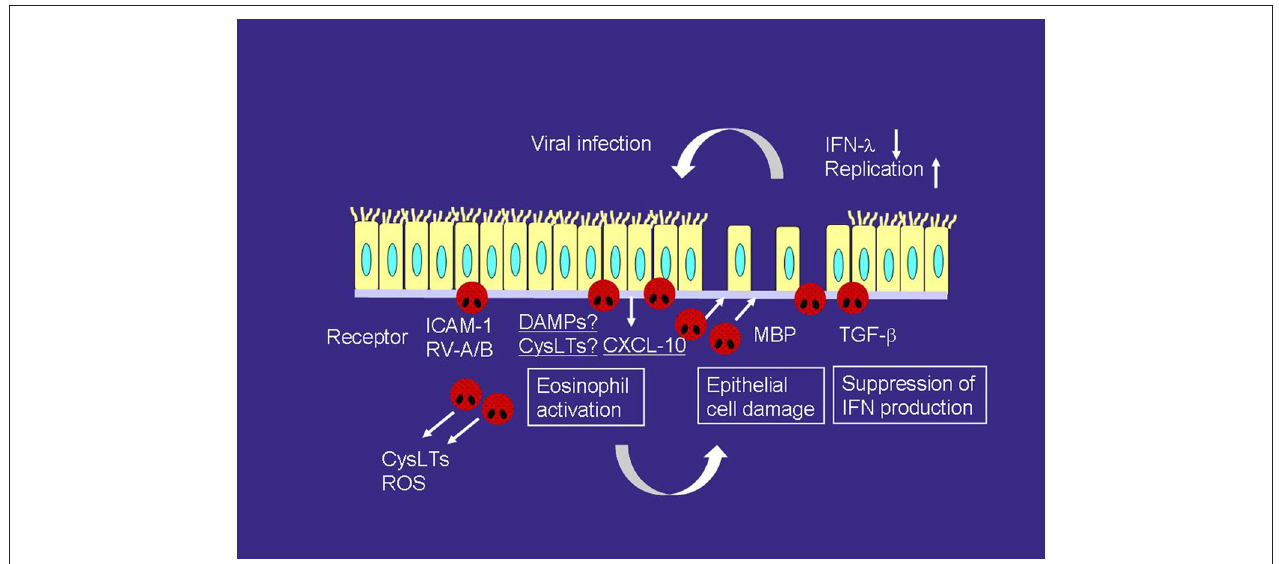
FIGURE 2 | Interactions of viral infection and eosinophils in the development of asthma exacerbation. RV infection releases a variety of mediators, including CXCL-10 and cysLTs, which can directly activate eosinophils and induce asthma exacerbation, from airway epithelial cells. RV infection increases the expression of ICAM-1, which also activates eosinophils. On the other hand, activated eosinophils release MBP, which induces epithelial cell damage. Eosinophils also produce TGF- β , which can suppress the expression of IFN- λ , anti-viral cytokines, on epithelial cells. Therefore, eosinophilic airway inflammation can increase susceptibility to RV infection. ROS, reactive oxygen species; TGF, transforming growth